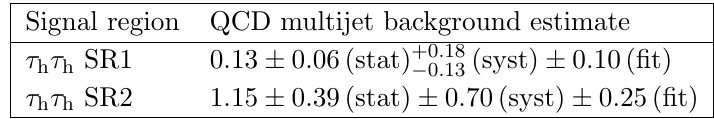
h (cid:28) h channel. The (cid:12)rst two